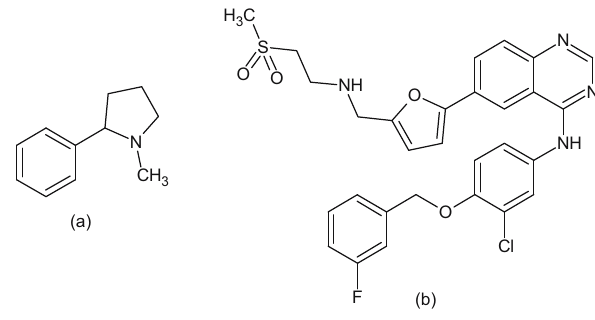
Figure 1: Chemical structures of ( a ) nicotine and ( b ) lapatinib ( IS )